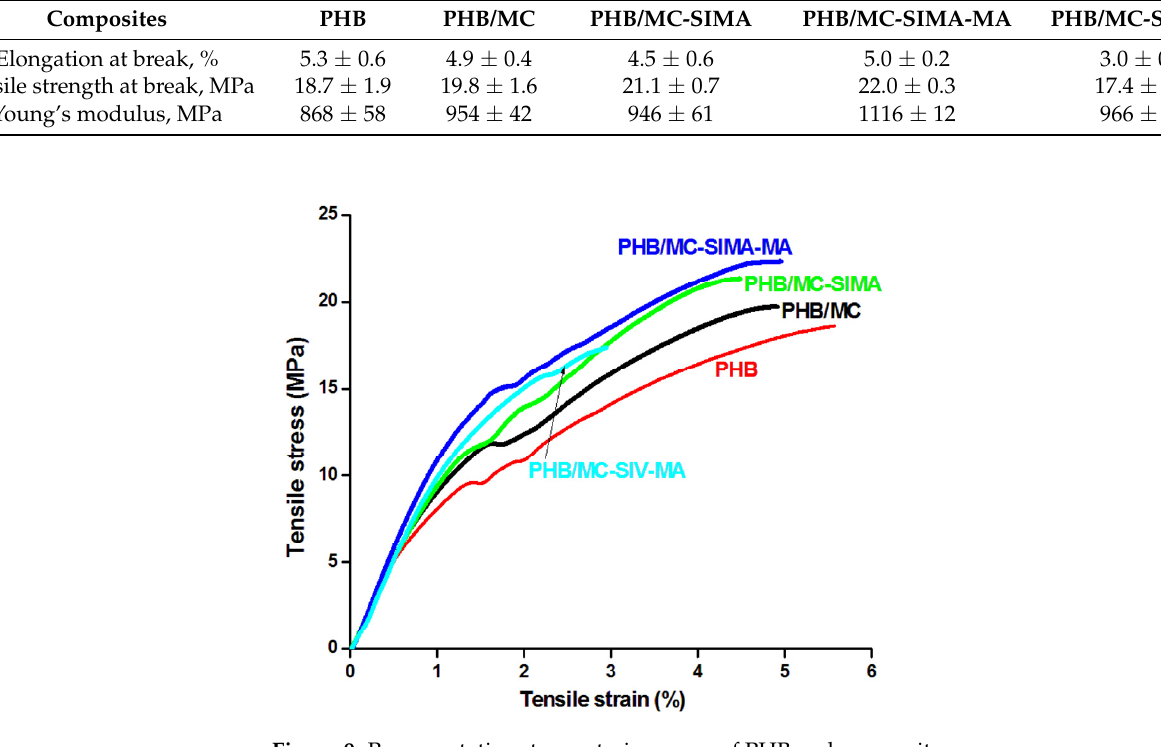
Figure 9. Representative stress–strain curves of PHB and composites .